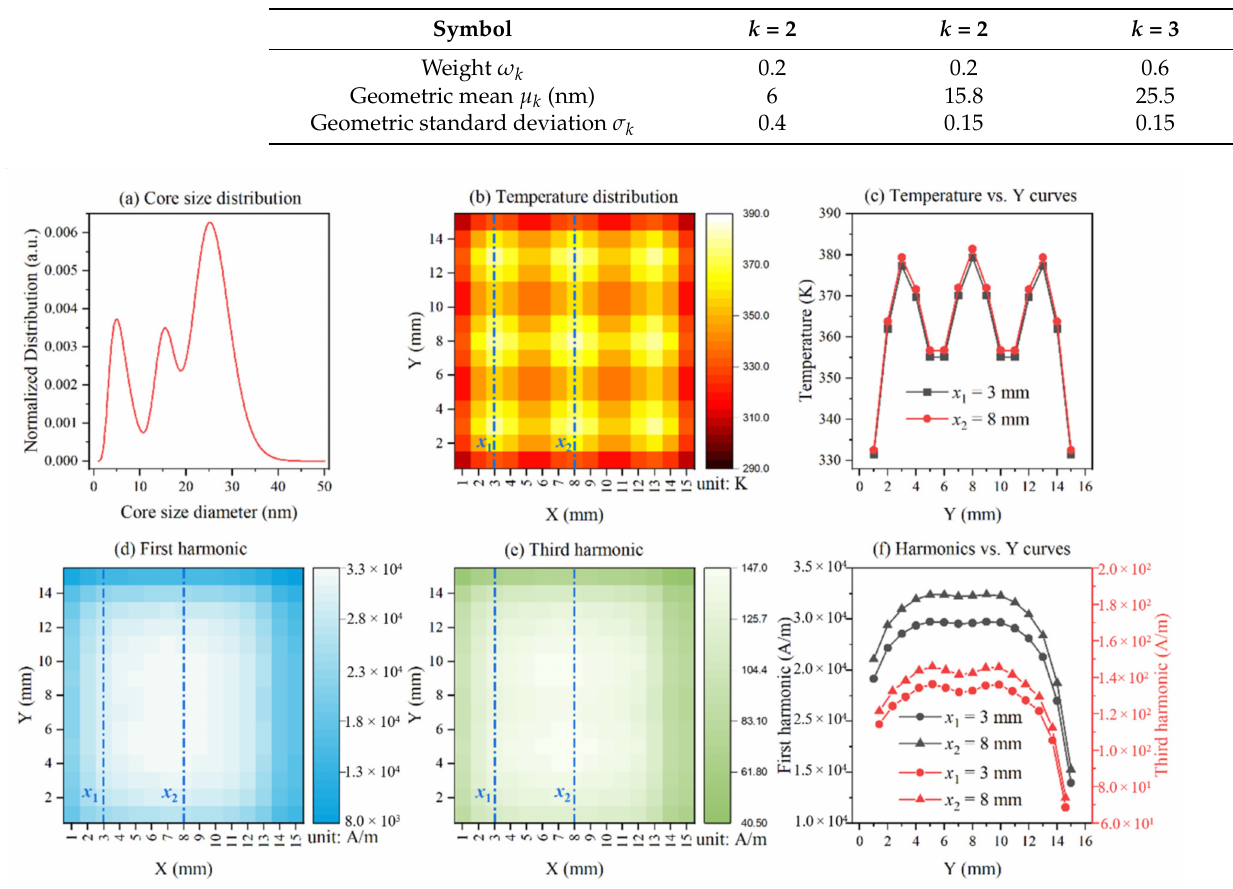
Table 1. Parameters of hypothetical core size distribution for MNPs.